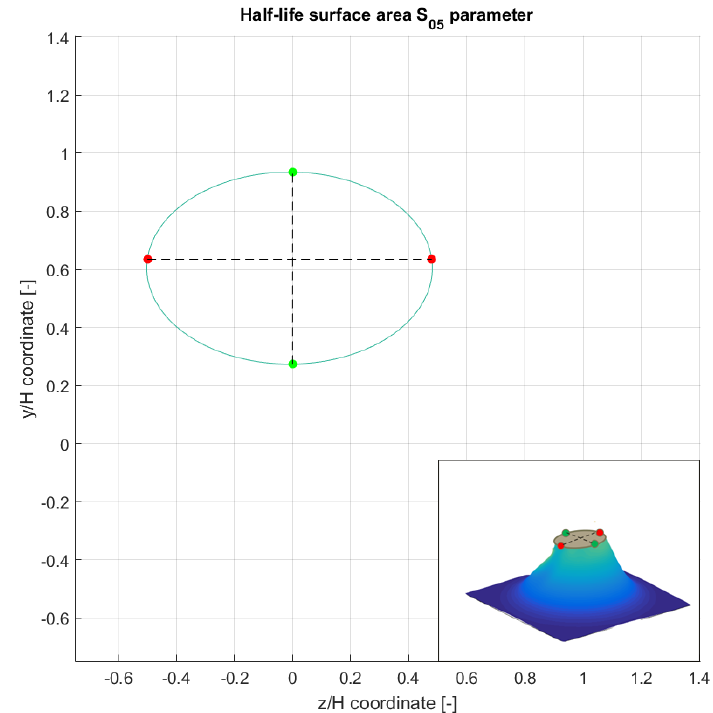
Figure 13. Elliptical fitting of the four points extracted at a level of w xmax /2. Spanwise origin fitted at vortex core location. A representative three-dimensional figure is